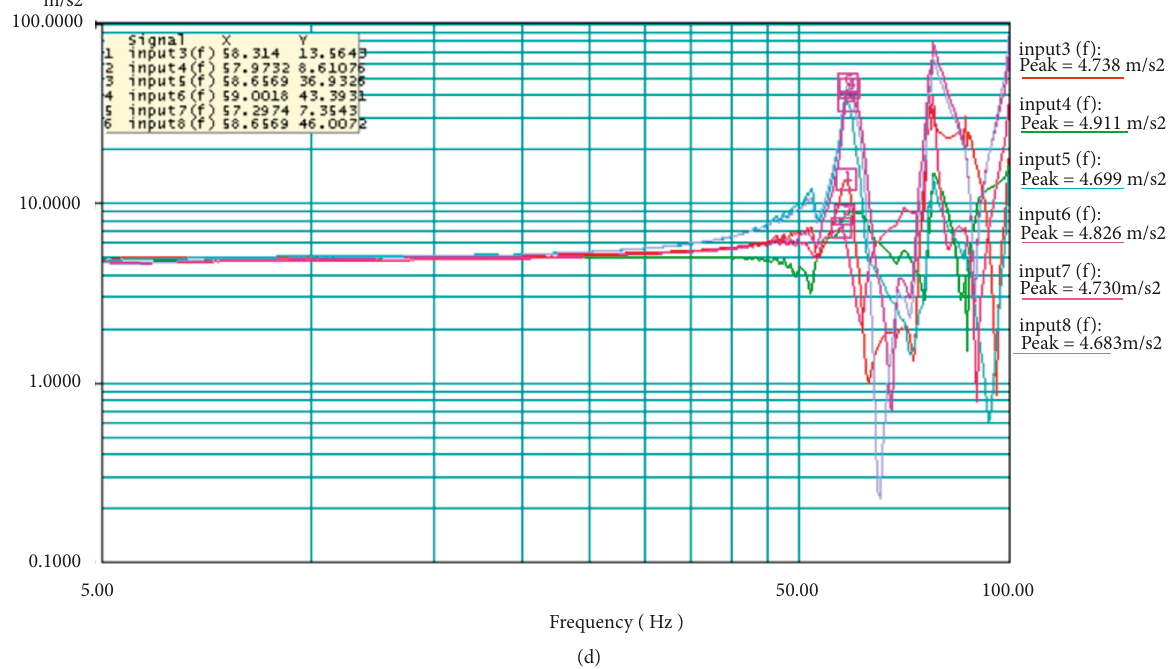
Figure 27: Resonance check test control curve and response curve. (a) 1# sweep frequency test piece resonance check test control curve; (b) 1# sweep test piece resonance check test response curve; (c) 2# sweep frequency test piece resonance check test control curve; and (d) 2# sweep frequency test piece resonance check test response